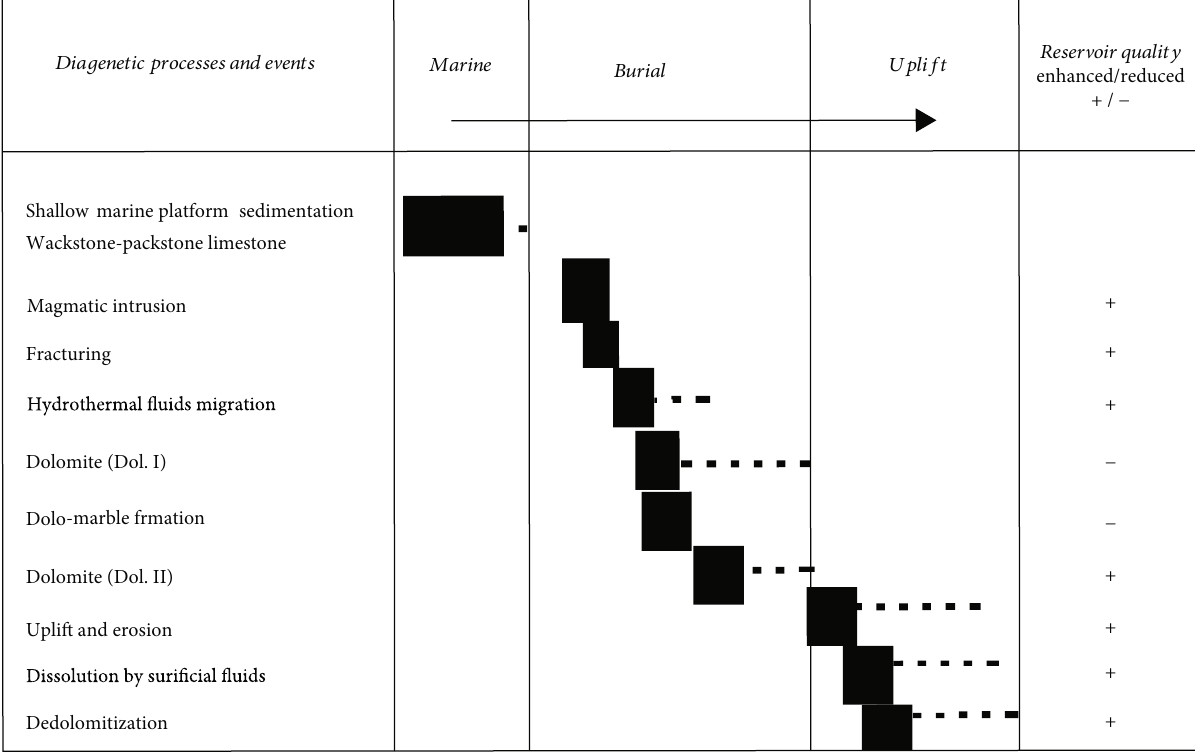
D i a g e n e t i c p r o c e ss e s a n d e v e n t s